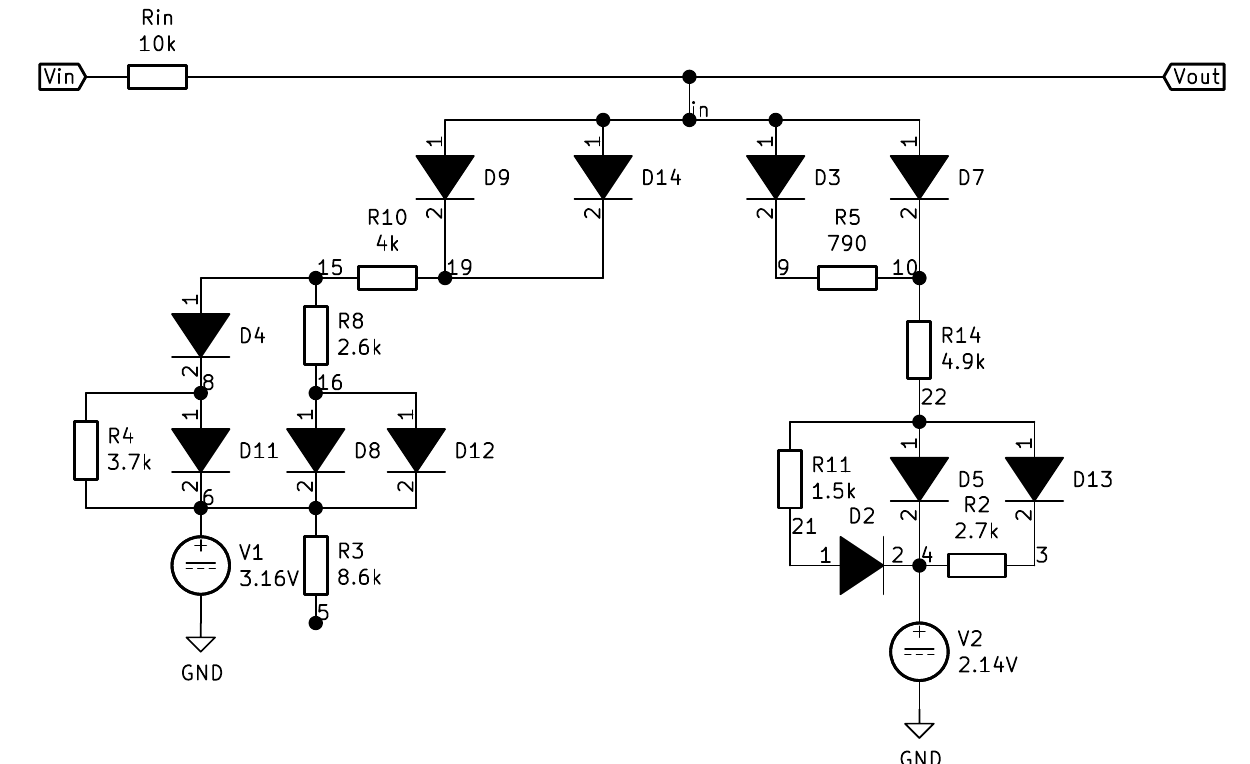
Figure 11. The evolved topology of a failure-tolerant natural logarithm circuit (raw evolution result). Table 3. The search parameters of the evolution of a failure-resilient natural logarithm analog circuit. Resistors